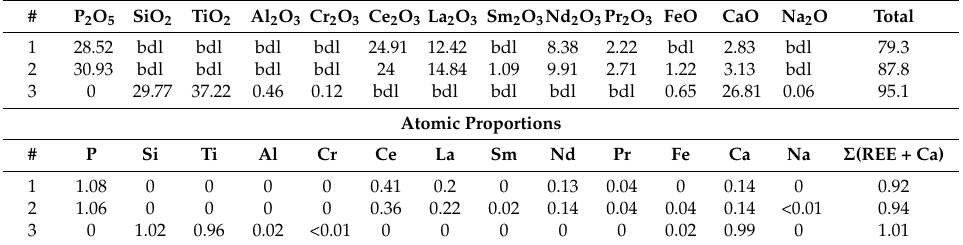
Table 5. Compositions of inclusions of REE- and Ti-rich minerals hosted by grains of platinum-group minerals from the Sisim placer zone, Eastern